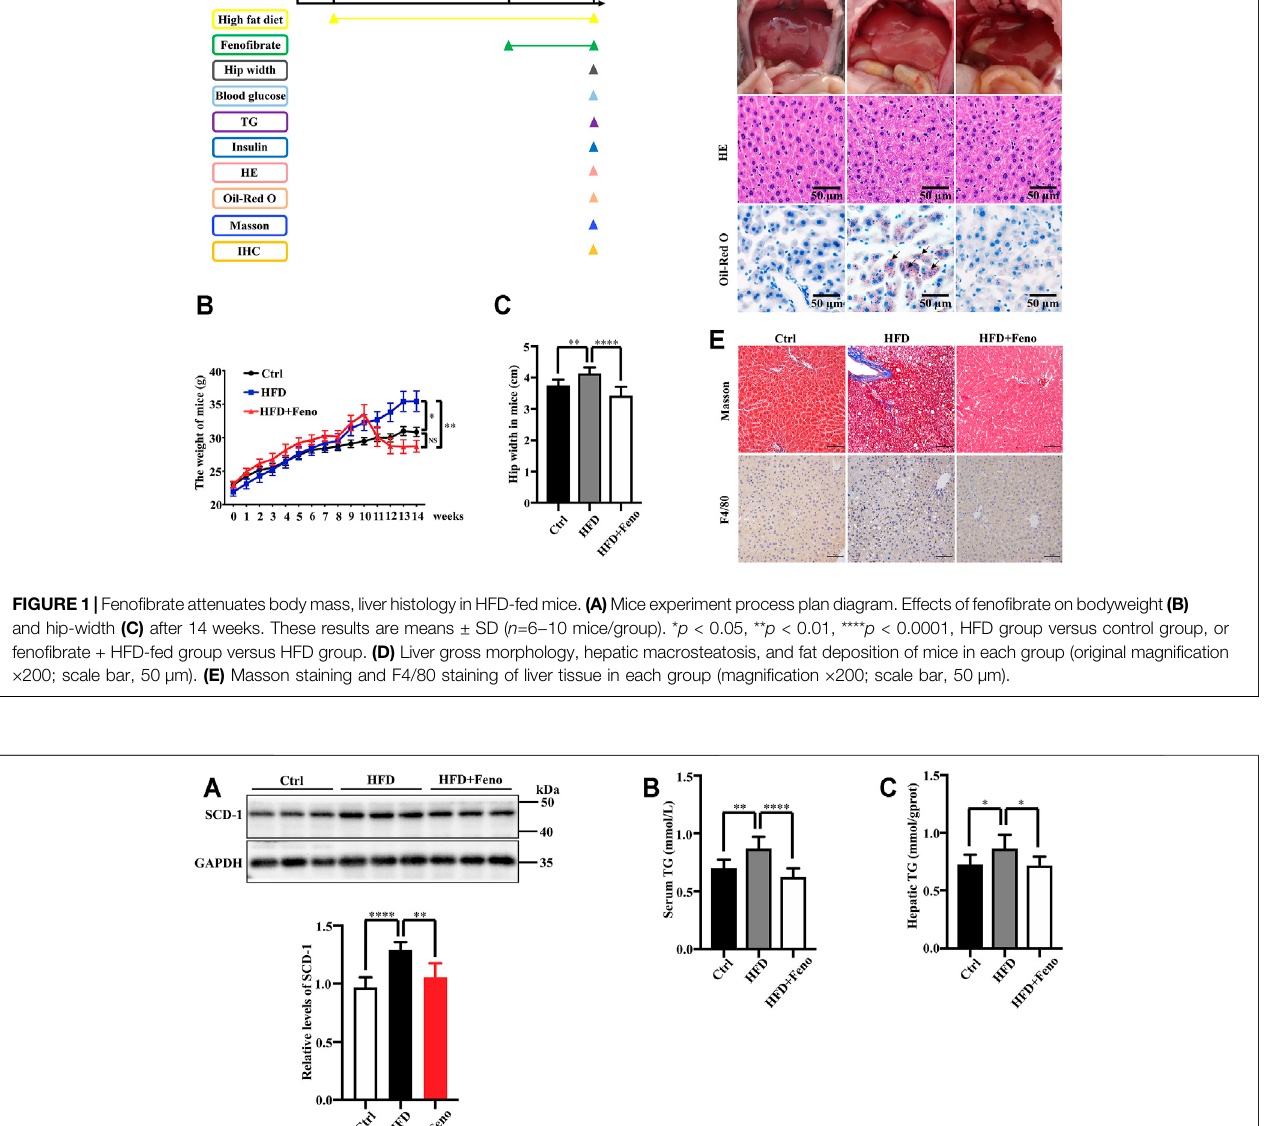
Frontiers in Pharmacology |